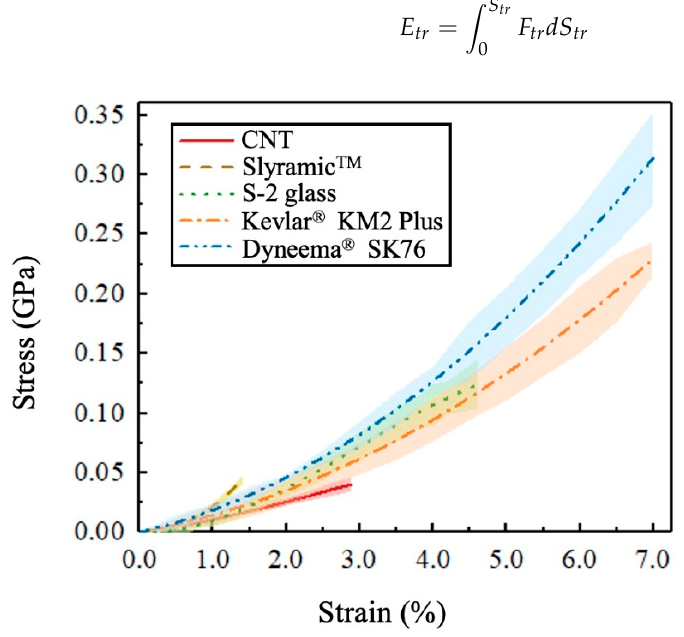
Figure 12. Force-deflection curves of different fibers.